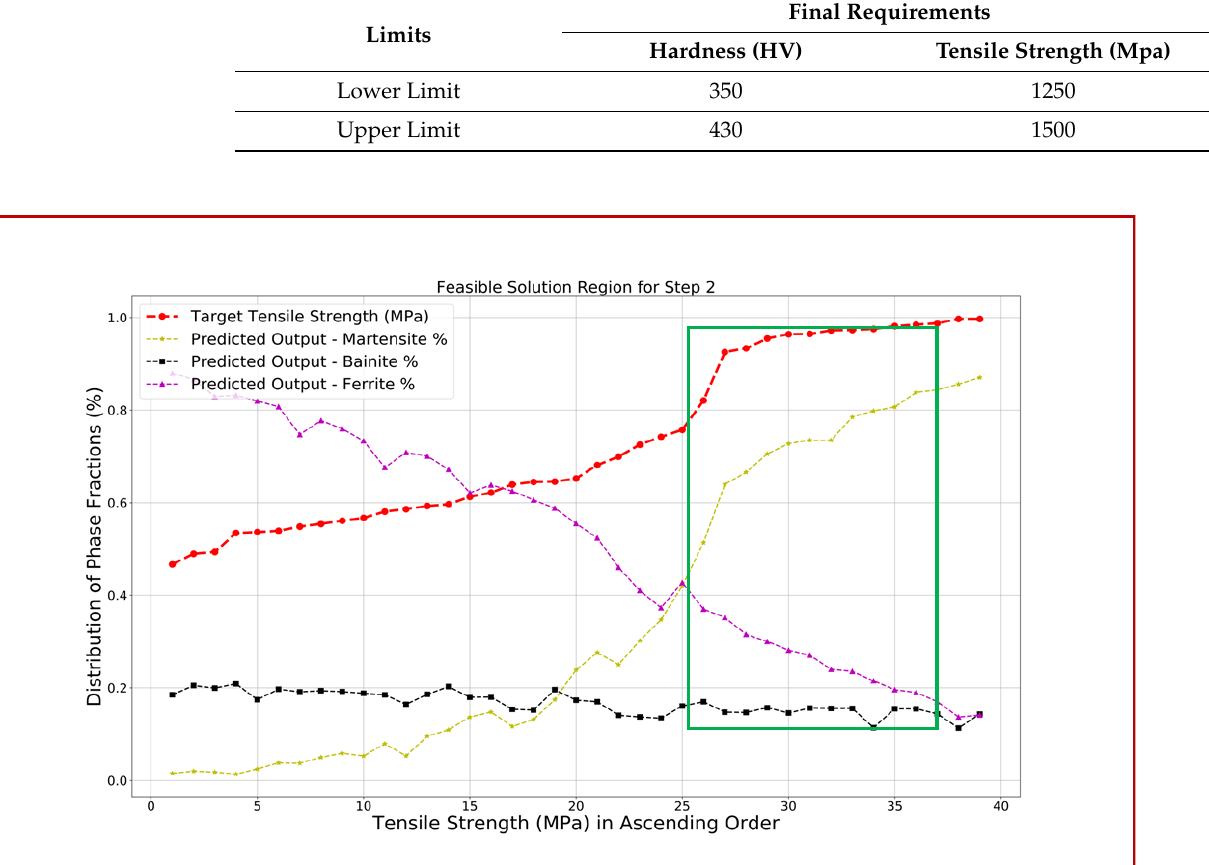
Table 7. Requirements on Mechanical Properties (Step 2).